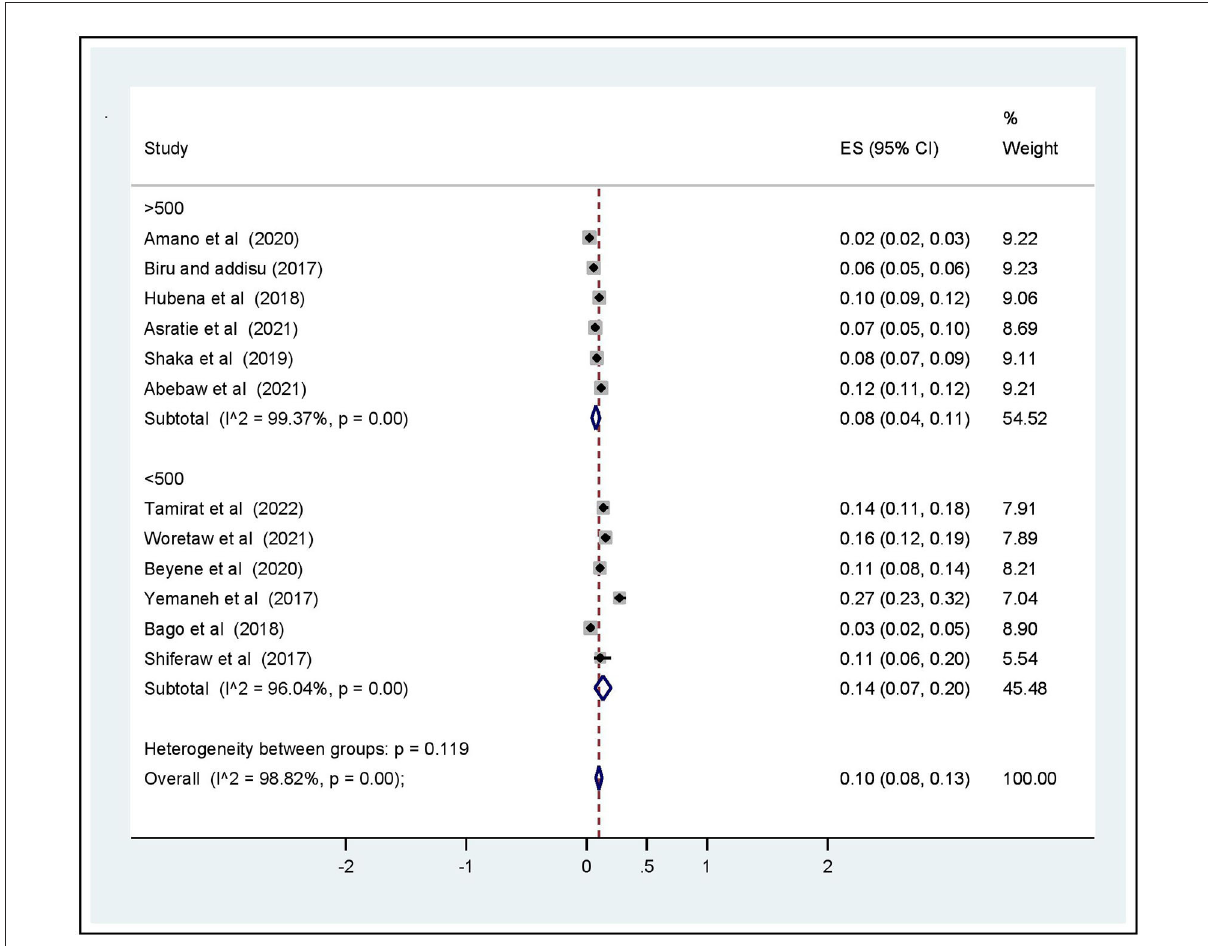
FIGURE6 Subgroup analysis based on sample size for prevalence of operative vaginal deliveries among mothers who gave birth in Ethiopia,